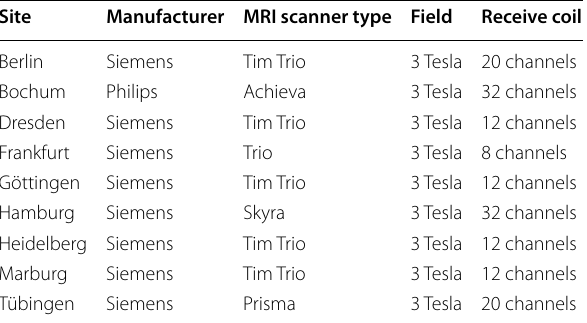
Table 5 List of MR scanners (manufacturer, scanner types, field strength) and receive coils at each study